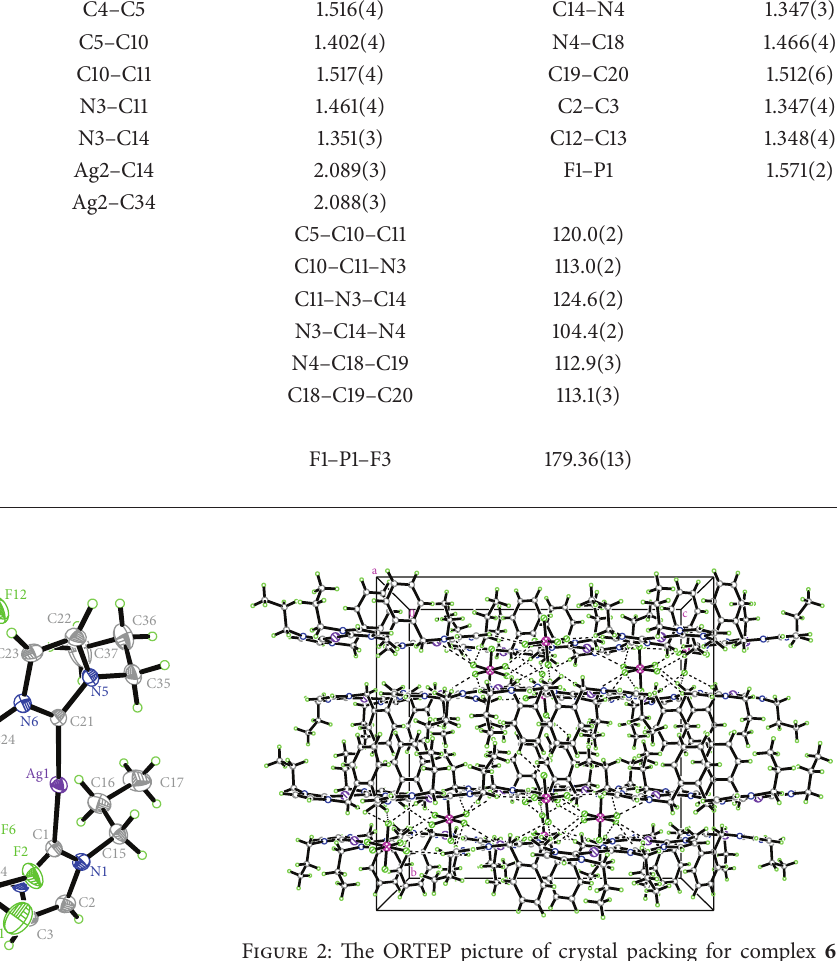
Figure 2: The ORTEP picture of crystal packing for complex 6 . The figure shows that molecules are connected by C–H ⋅⋅⋅ F bonding (orthorhombic).